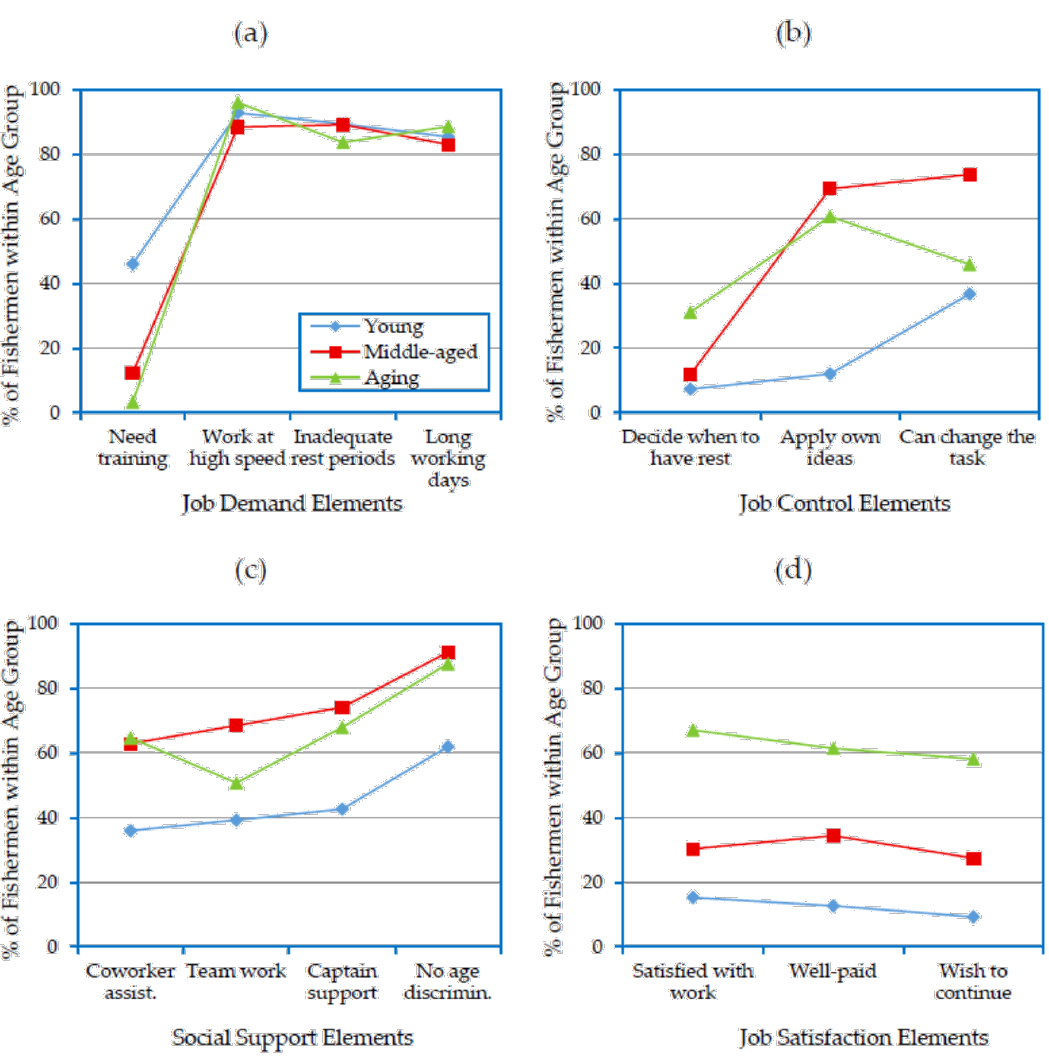
Figure 6. Factors affecting job content among fishermen age groups: ( a ) job demand; ( b ) job control; ( c ) social support; and ( d ) job satisfaction.